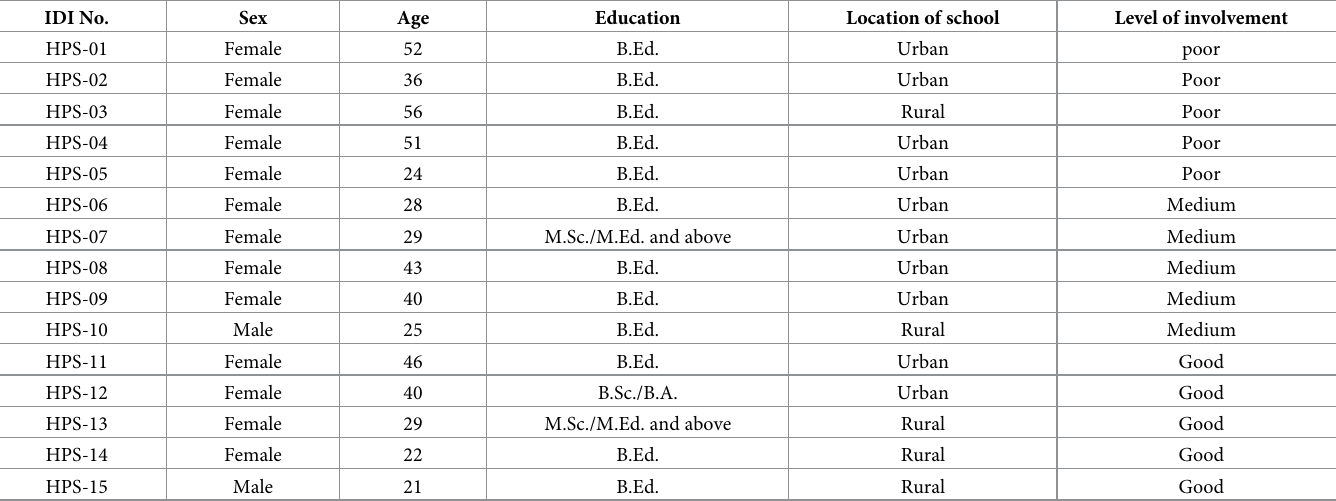
Table 4. Characteristics of in-depth interviews among high school teachers by the level of involvement (n = 15). IDI